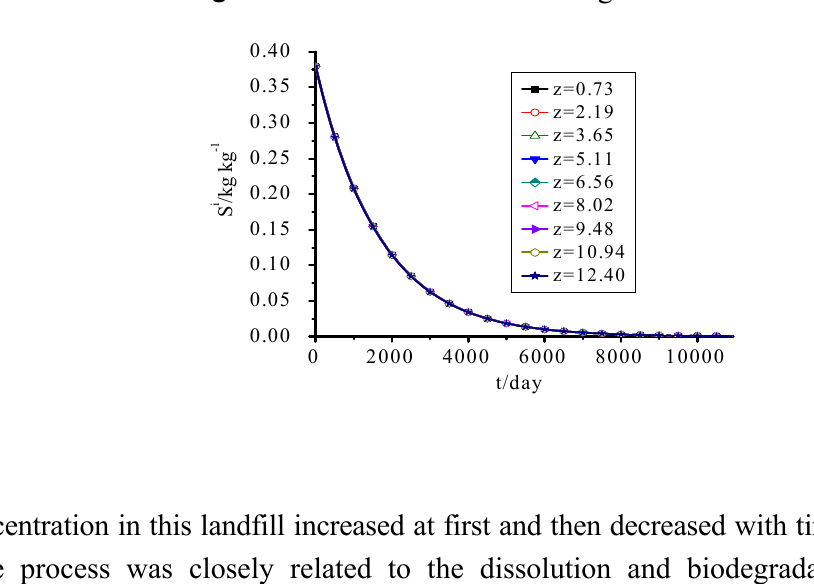
Figure 6. IDS Concentration change with